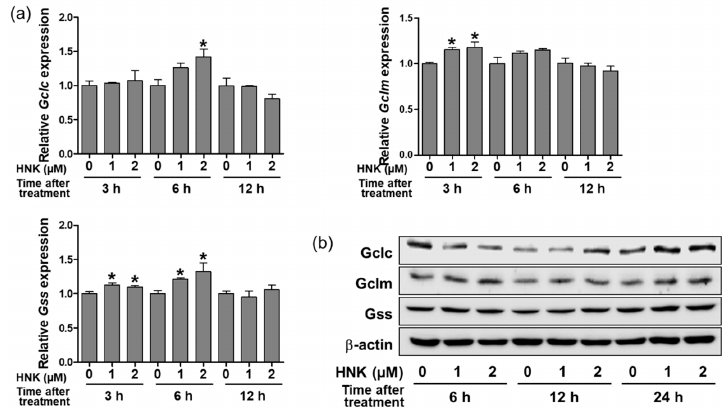
Figure 2. Honokiol increases the expression of GSH biosynthetic enzymes in HK ‐ 2 cells. ( a ) Cells were treated with honokiol (0, 1, or 2 μ M) for 3, 6, or 12 h and the mRNA expression of Gclc, Gclm, and Gss was determined by real ‐ time PCR analysis. Relative mRNA levels were normalized to those of GAPDH. ( b ) Cells were treated with honokiol (0, 1, or 2 μ M) for 6, 12, or 24 h and the protein expression of Gclc, Gclm, and Gss was determined by Western blot analysis. Relative protein levels were normalized to those of β‐ actin. Values are expressed as the means ± S.E.M. of three independent experiments. * p < 0.05 significant compared with the vehicle control.